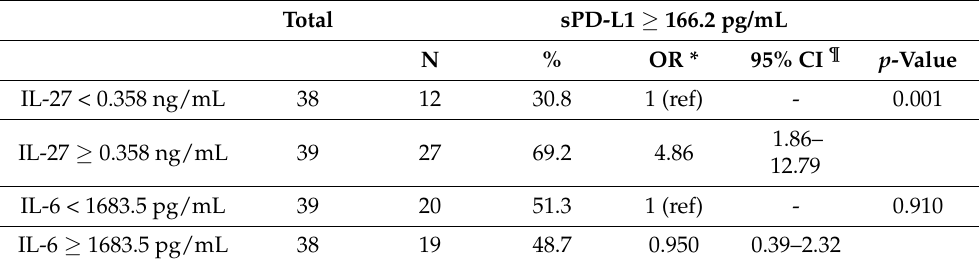
Table 1. Association of sPD-L1 concentration with IL-27 and IL-6 concentrations.